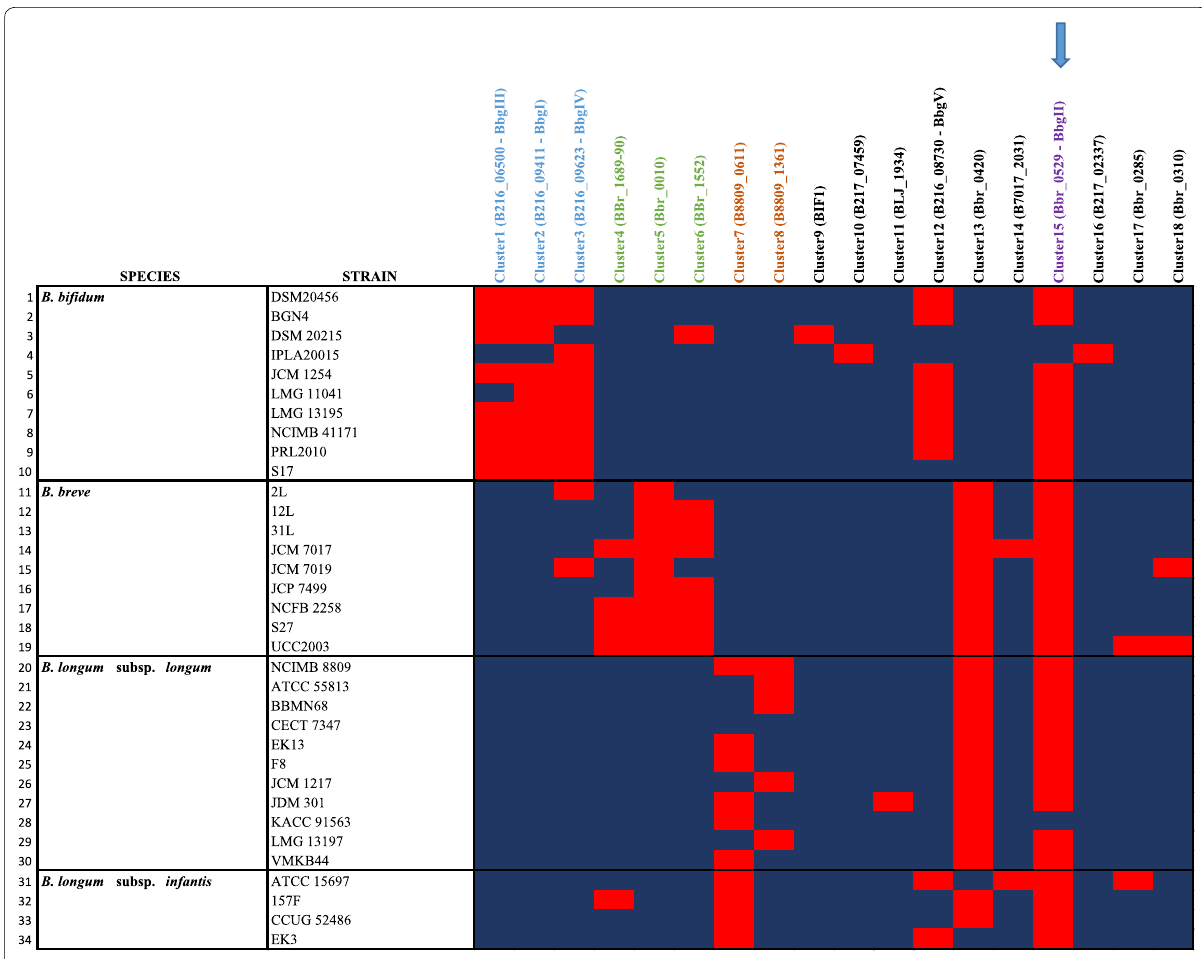
Fig. 1 Comparative analysis of β-galactosidases in infant-derived bifidobacterial (sub)species. Heatmap showing presence (red) and absence (blue) of 18 clusters of β-galactosidase-encoding genes across the 34 bifidobacterial representatives of B. breve , B. bifidum , B. longum subsp. longum and B. longum subsp. infantis . A blue arrow highlights Cluster 15, which is present across members of all the four (sub)species, while blue, green and brown colours identify clusters observed only in B. bifidum , B . breve and B. longum species,